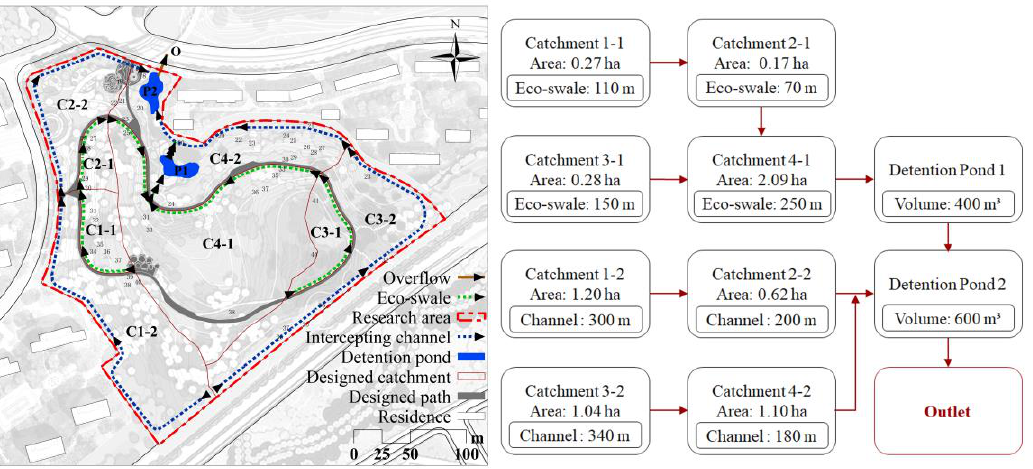
Figure 7. Facilities layout and design workflow diagram for S3.